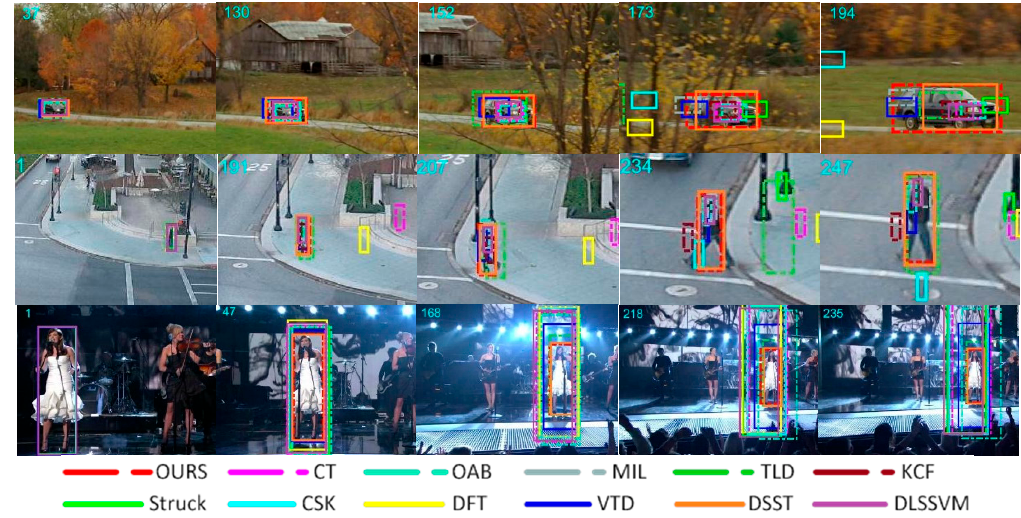
Figure 3. Tracking results of the proposed method and eleven state-of-the-art tracking methods on sequences Carscale , Human6 , and Singer1 . In these sequences, there is a scale variation problem.